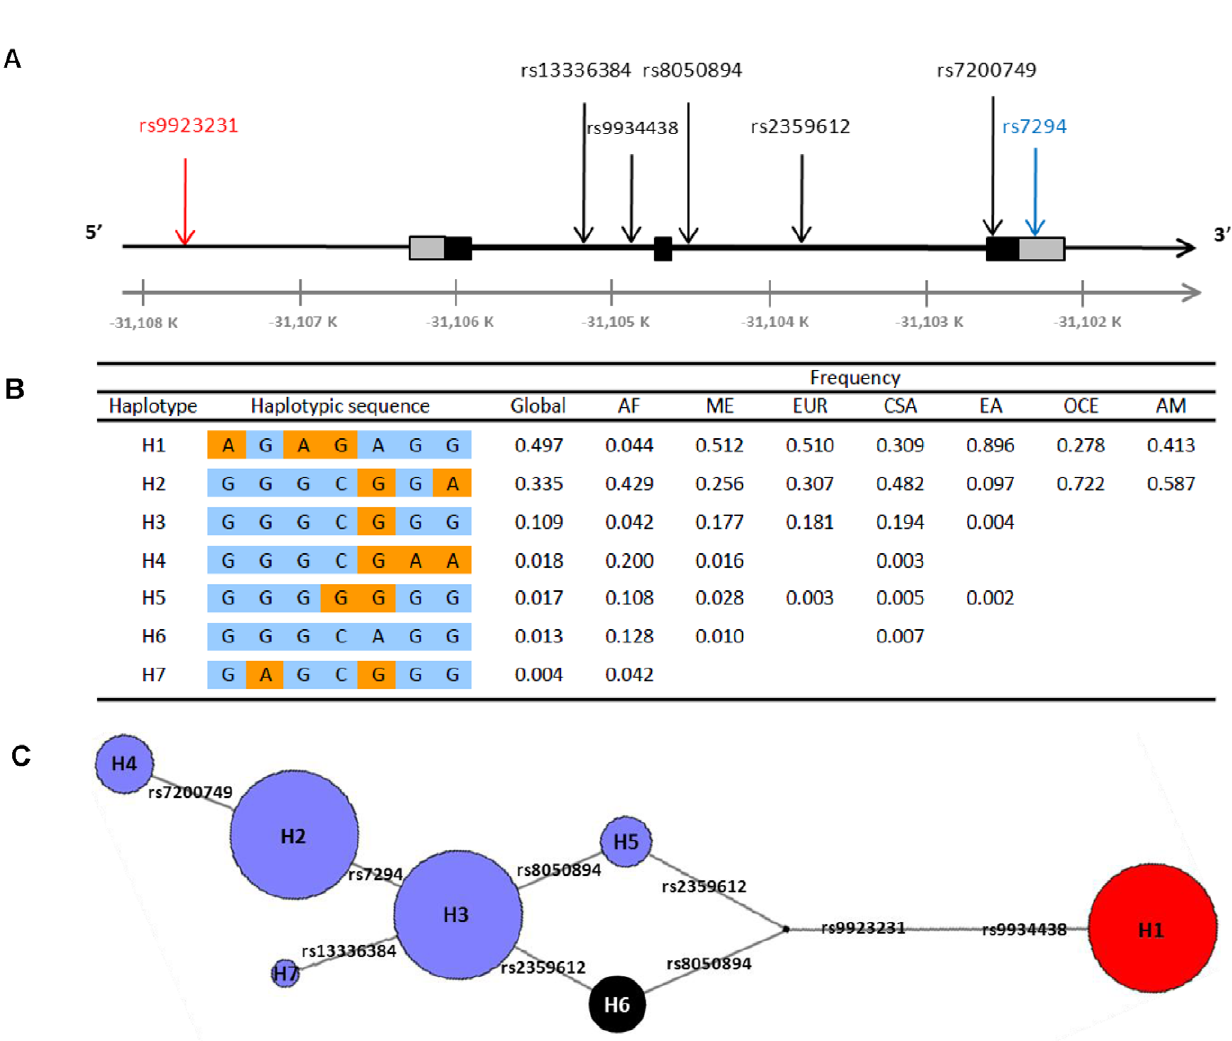
Figure 1. Results of the VKORC1 haplotype study. ( A ) Position of the seven SNPs along the VKORC1 gene. VKORC1 is a 4.1 kb gene (GenBank accession number AY587020) located at 16p11.2. The three exons of the gene are represented as boxes, with 5 9 UTR and 3 9 UTR regions colored in grey and coding regions in black. Flanking and intronic regions are represented as thin and thick lines, respectively. The seven studied SNPs are shown in their sequential order along the VKORC1 gene. The functional polymorphism rs9923231 located in the promoter, is highlighted in red and the SNP already present in the Illumina 650K chip in blue. Physical position along chromosome 16 is indicated in kb below. ( B ) Distribution of VKORC1 haplotypes at the global and regional level. For each haplotype, SNPs are listed in the same sequential order than in Figure 1A. Ancestral and derived alleles are shown in blue and orange, respectively. Haplotype labels H1 to H7 were given according to the global haplotype frequency. AF, sub-Saharan Africa; ME, Middle East; EUR, Europe; CSA, Central South Asia; EA, East Asia; OCE, Oceania; AM, America. ( C ) Median- joining network of the inferred VKORC1 haplotypes at the global level. Circles areas are proportional to the global haplotype frequency and branch lengths to the number of mutations separating haplotypes. Labels of haplotypes are indicated in corresponding circles, and labels of mutations on the network branches. The haplotype carrying the -1639A allele conferring the AVK sensitivity phenotype (H1) is shown in red and the ancestral haplotype (H6) in black. Figure S3). At the intra-regional level, i.e. among populations genome-wide distribution ( F ST = 0.32, p =0.008) (Figure 2A). within a region, no extreme pattern of genetic differentiation When global F ST values were computed among the 52 world ( p , 0.01) was observed for any VKORC1 SNP in any geographic populations, very similar results were obtained (Table S1). At the region (Table 1 and Figure S4). inter-regional level, i.e. between a given geographic region and the remaining ones, the same four VKORC1 SNPs showed highly The XP-CLR test applied to each geographic region also significant F ST values ( p , 0.01) when comparing Central South provided evidence of an atypical pattern of genetic differentiation Asia and East Asia to the rest of the world (Table 1, Figures 2B at the VKORC1 gene locus, with XP-CLR scores in East Asia and 2C). Regarding East Asia, the highest F ST values ( F ST = 0.41, ranging from 16.53 ( p =0.050) to 43.44 ( p = 0.012) in the 16 kb p =0.003) were also observed for the two SNPs, rs9923231 and genomic region centered on VKORC1 (Table 2). For each of the rs9934438. For the other geographic regions, no VKORC1 SNP other six geographic regions, the XP-CLR scores were very low, displayed an inter-regional F ST value as much significant as the supporting the existence of a selective sweep restricted to East ones observed for Central South Asia and East Asia (Table 1 and Asia. In this geographic region, when the XP-CLR test was